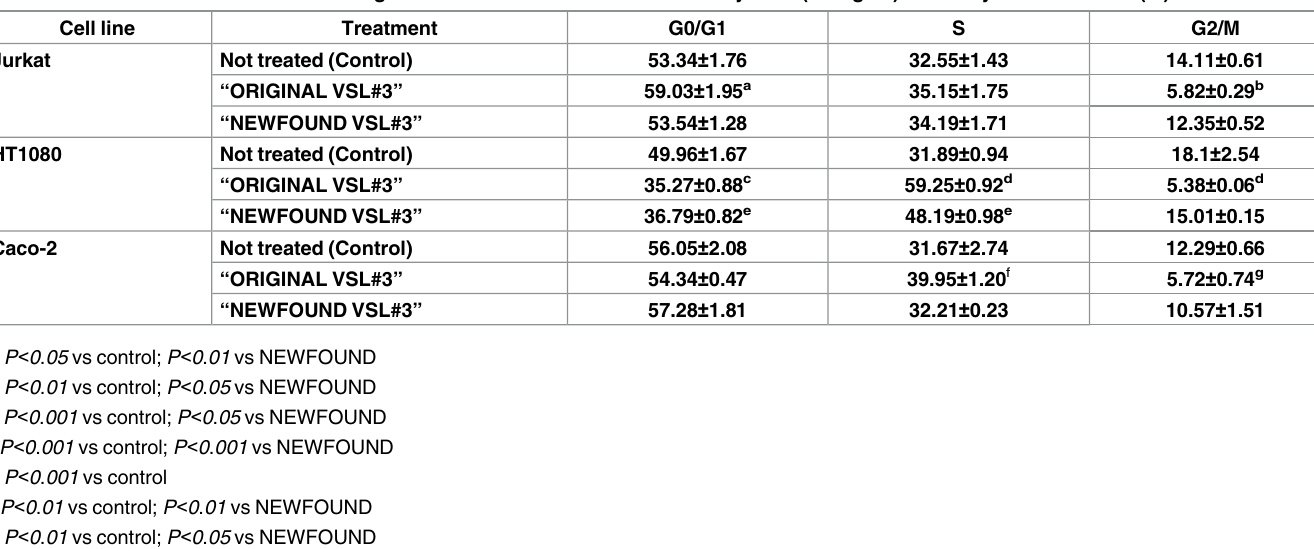
Table 1. Effect of 24 h treatment with “original” or “newfound” VSL#3 bacterial lysates (10 mg/ml) on cell cycle distribution (%). Cell